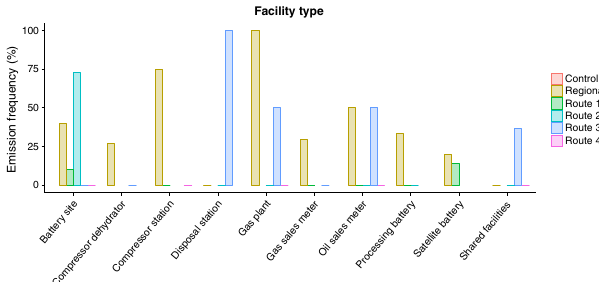
Figure 8. Emission frequencies for each facility type for all sur- veyed facilities on each route. These emission frequencies were considered in our total emission inventory calculations, along with the emission frequencies for wells in Fig.